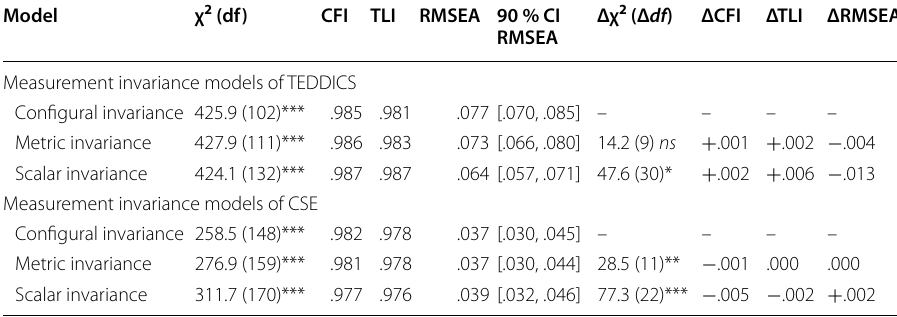
The configural invariance model was used as the reference for model comparisons. N * p < .05, ** p < .01, *** p < .001, ns statistically insignificant ( p > .05)